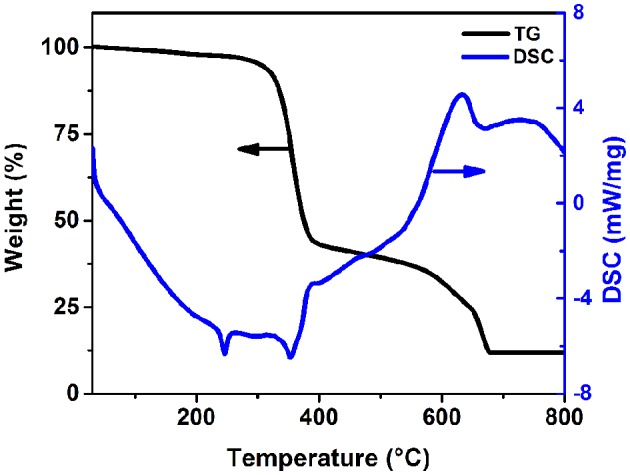
TGA and DSC data for (1-mPQBr)2MnBr4.